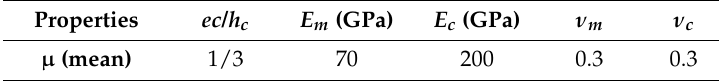
Table 3. Parameters mean values: case 3.2.1—Thinner